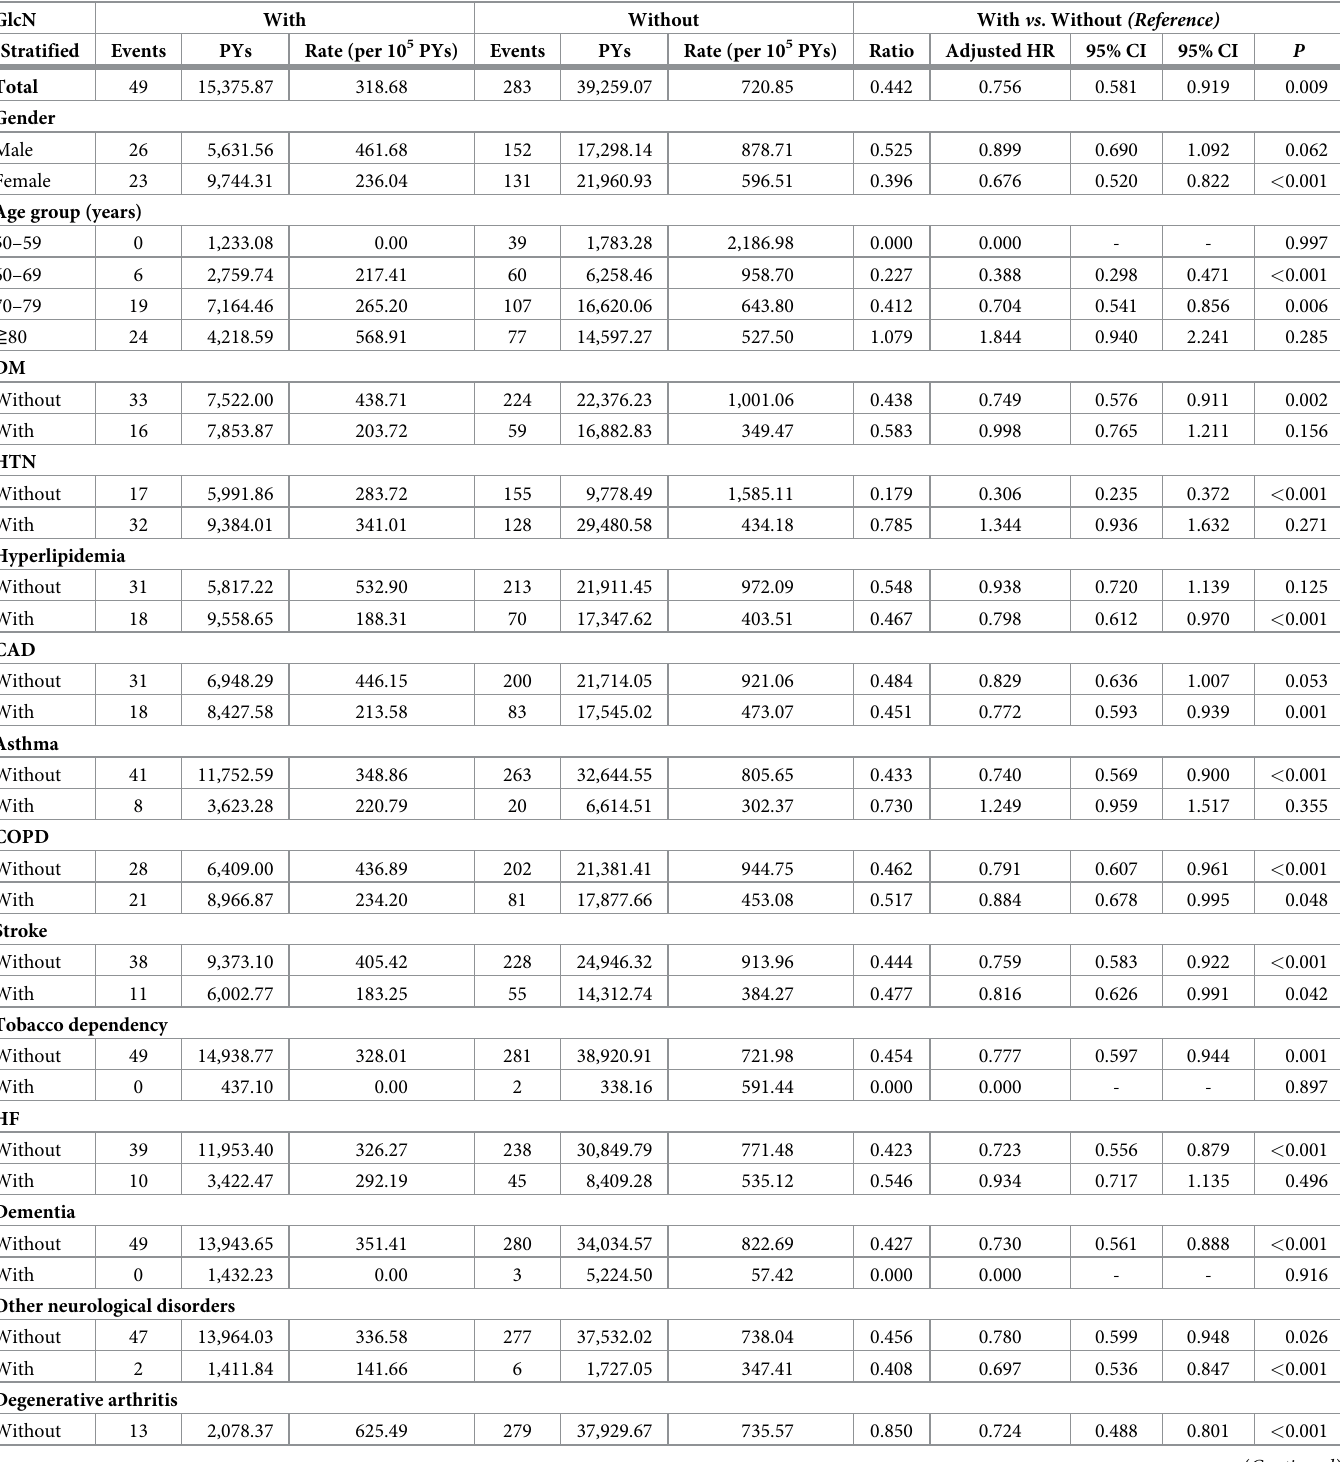
Table 3. Stratified Cox regression analyses comparing the risk of developing AMD between the two cohorts according to background factors. GlcN With Without With vs . Without